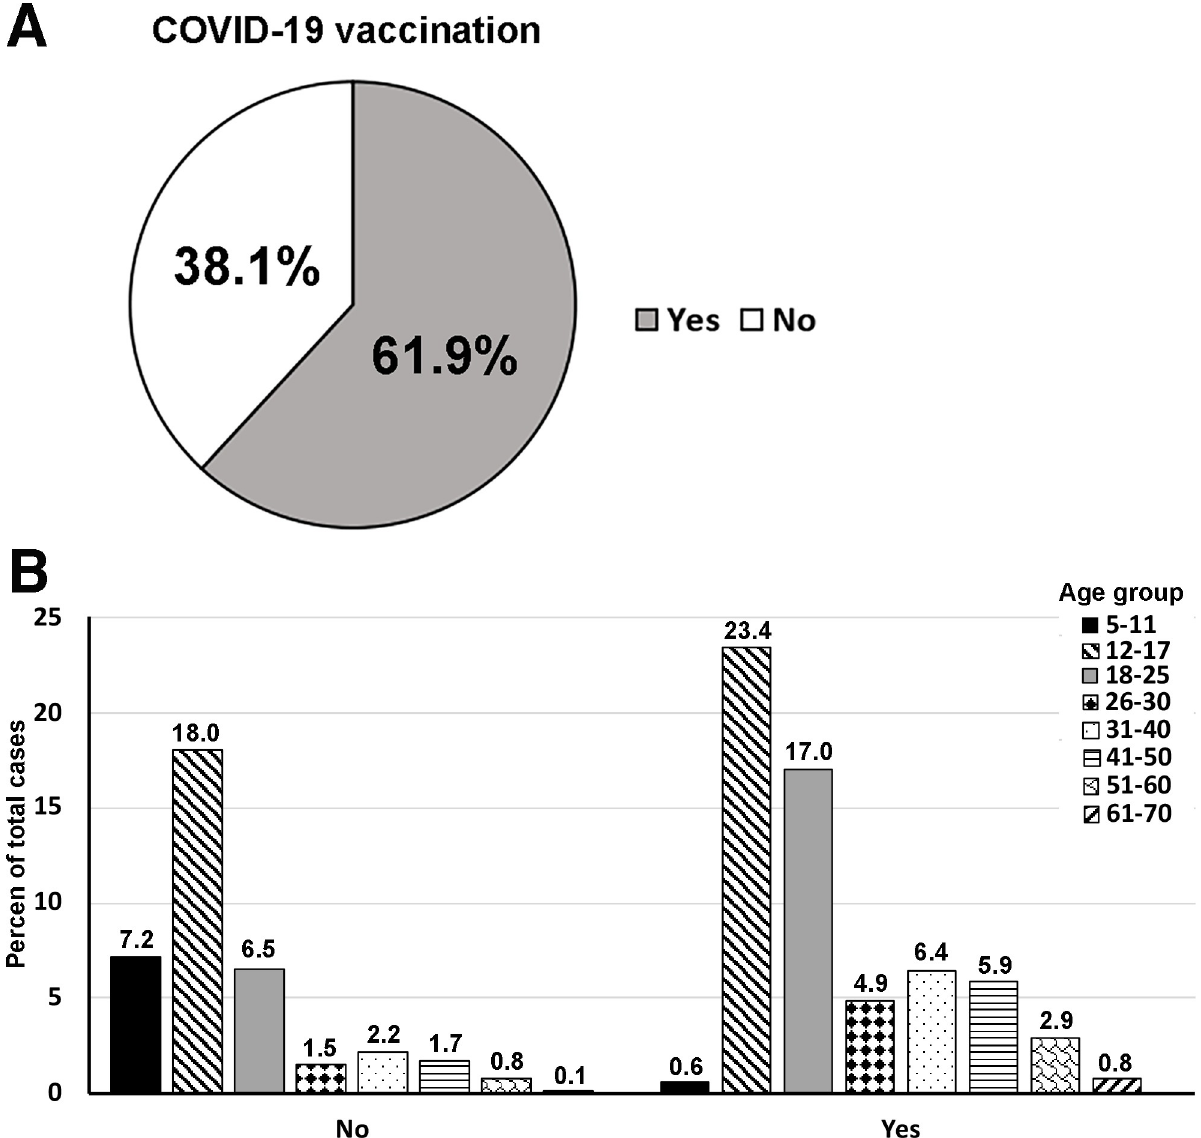
Fig 4. Distribution of participants by COVID-19 vaccination status. Approximately 62% of participants received full doses of COVID-19 vaccination (A). The vaccination status by age groups showed the highest number of the vaccinated group was aged 12–17 years old (B).